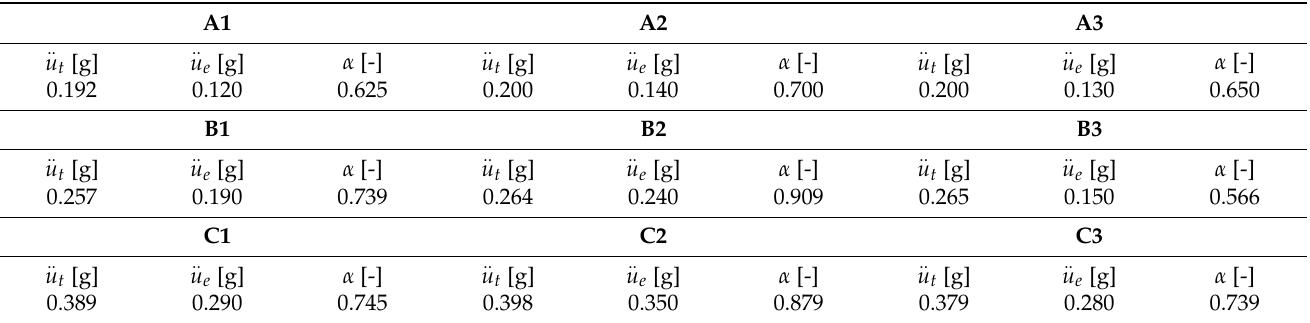
Table 2. Comparison between theoretical ( t ) and experimental ( e ) uplift accelerations for each block and corresponding reduced uplift coefficient.